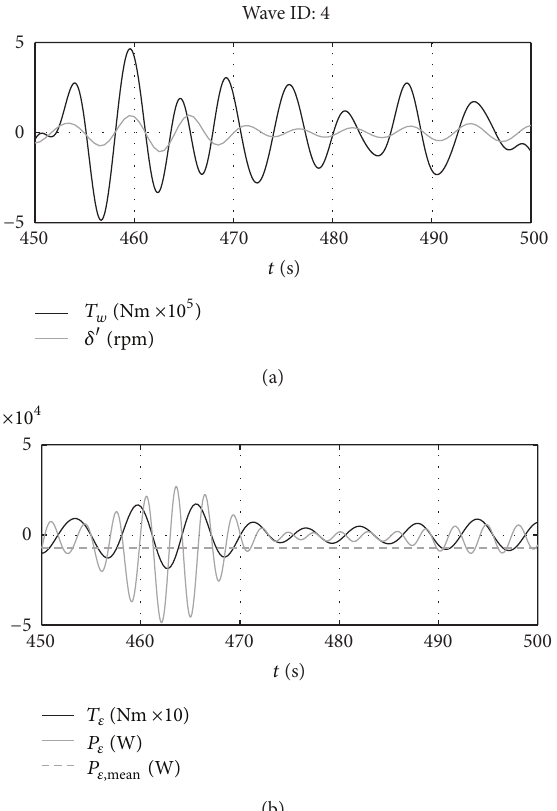
Figure 4: Time histories of the main system variables. (a) Wave excitation force versus pitch speed and (b) PTO torque and power.